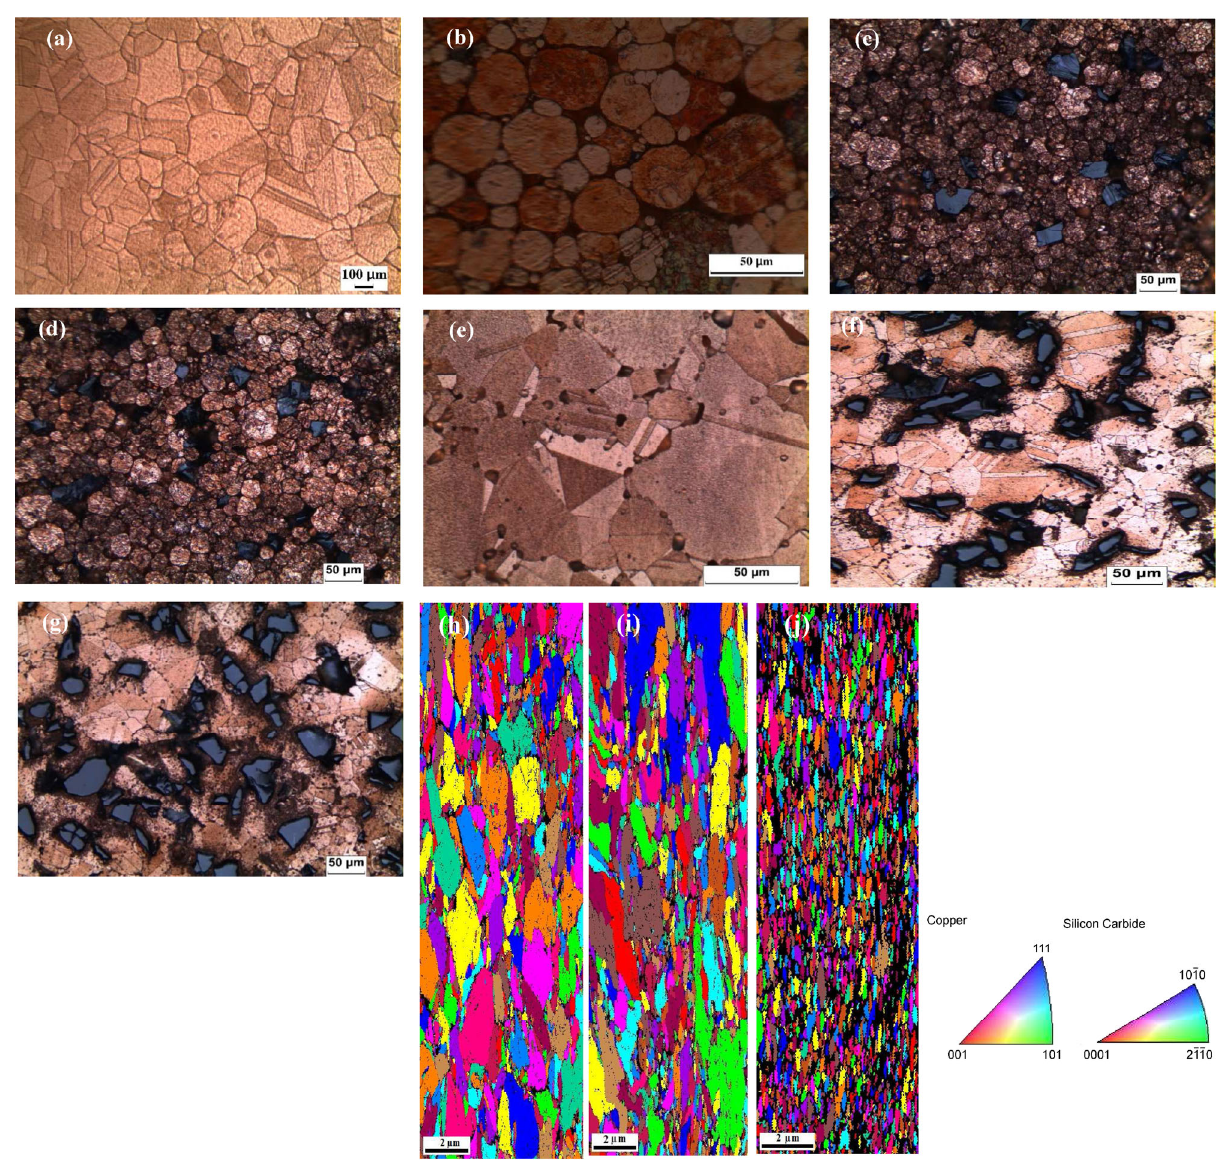
Fig. 4 OM photomicrographs of the microstructure of (a) Cu as-cast, (b) Cu, (c) Cu-10, and (d) 20%SiC cold compacted samples, (e) Cu, (f) Cu-10, and (g) 20%SiC sintered samples, and EBSD color-coded orientation map images of (h) Cu, (i) Cu-10, and (j) 20%SiC HPTed